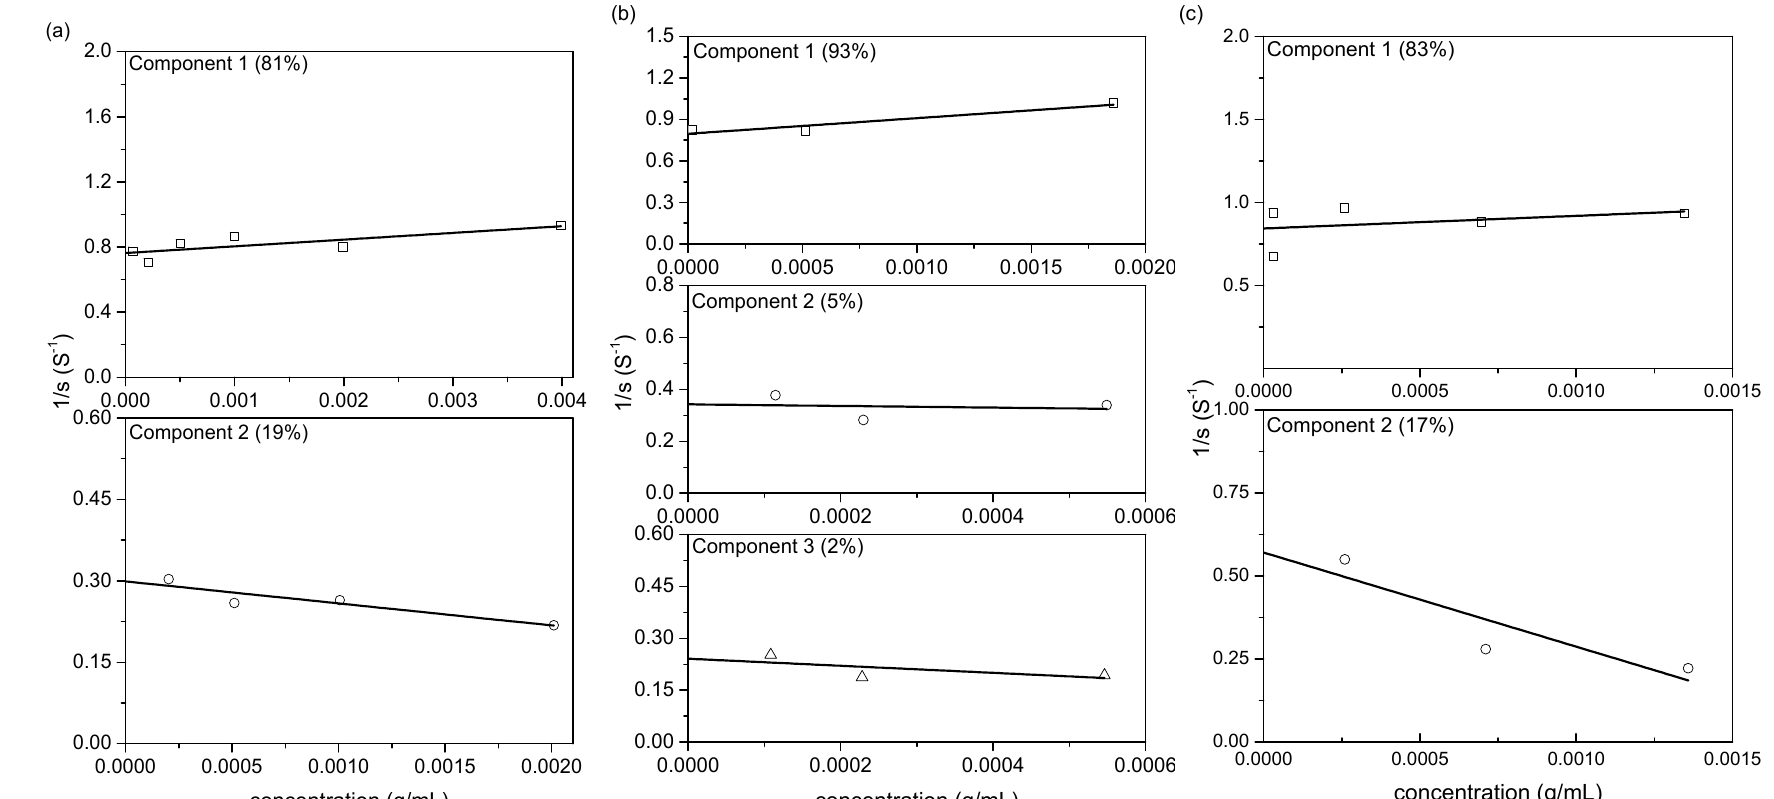
ffi cient ( a ) NJBTF1, ( b ) NJBTF2, ( c )